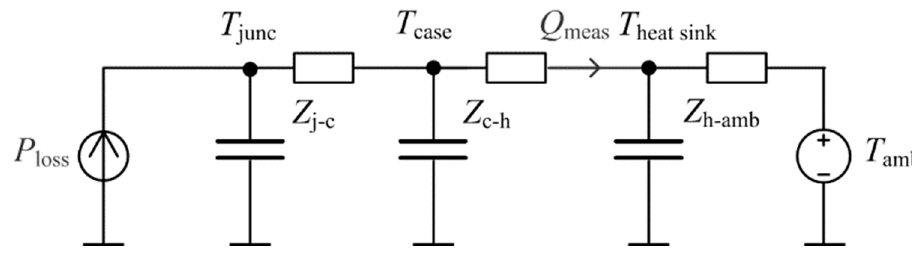
Figure 6. Thermal model of IGBT module.